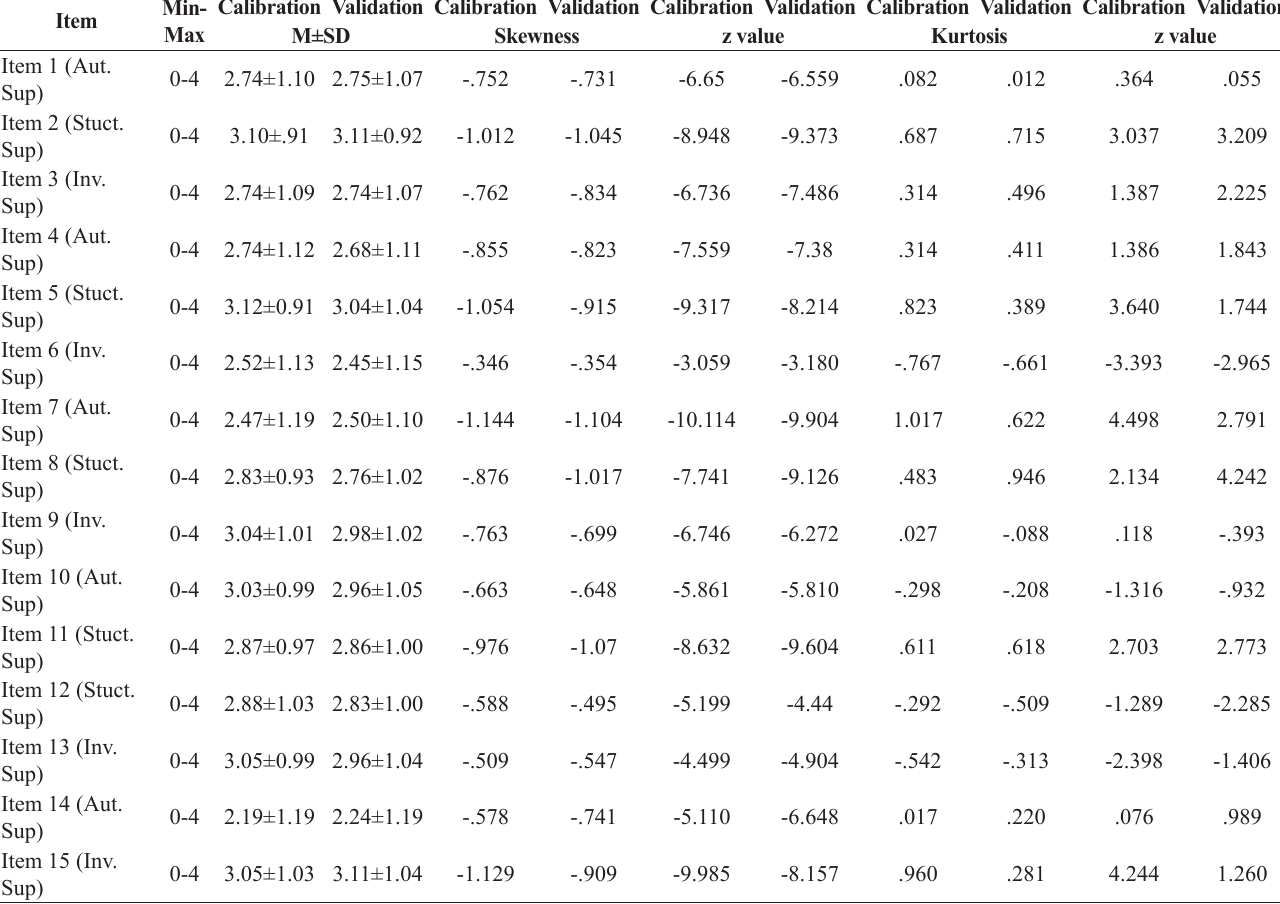
Table 1. Descriptive analysis of the answers to the items in the calibration and validation samples of PESS Item